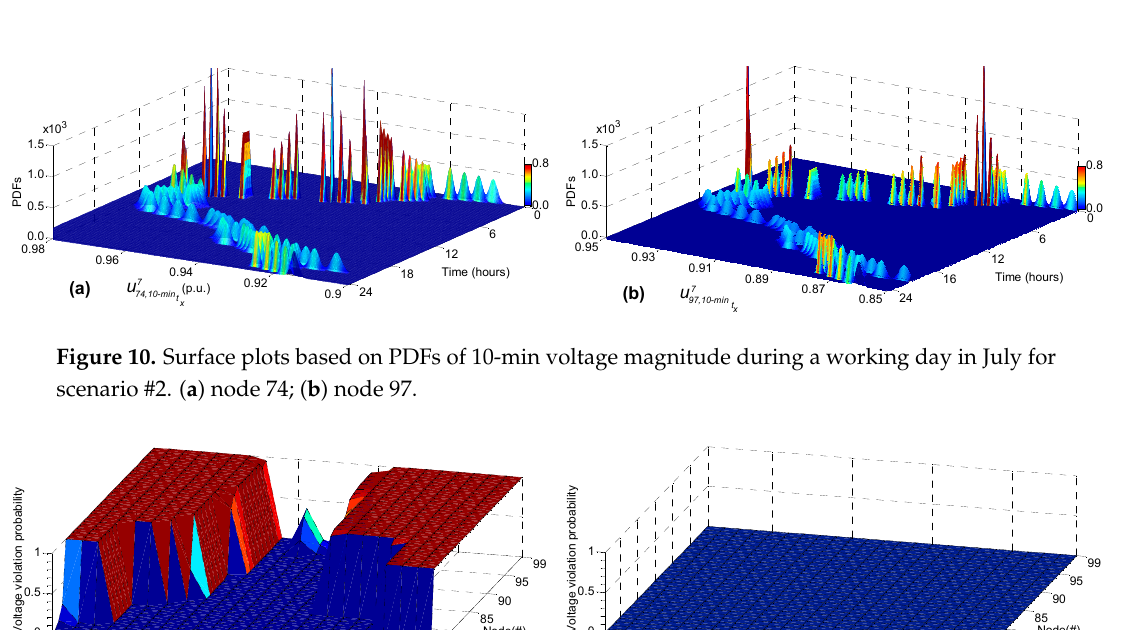
Figure 10. Surface plots based on PDFs of 10-min voltage magnitude during a working day in July for scenario #2. ( a ) node 74; ( b ) node 97.